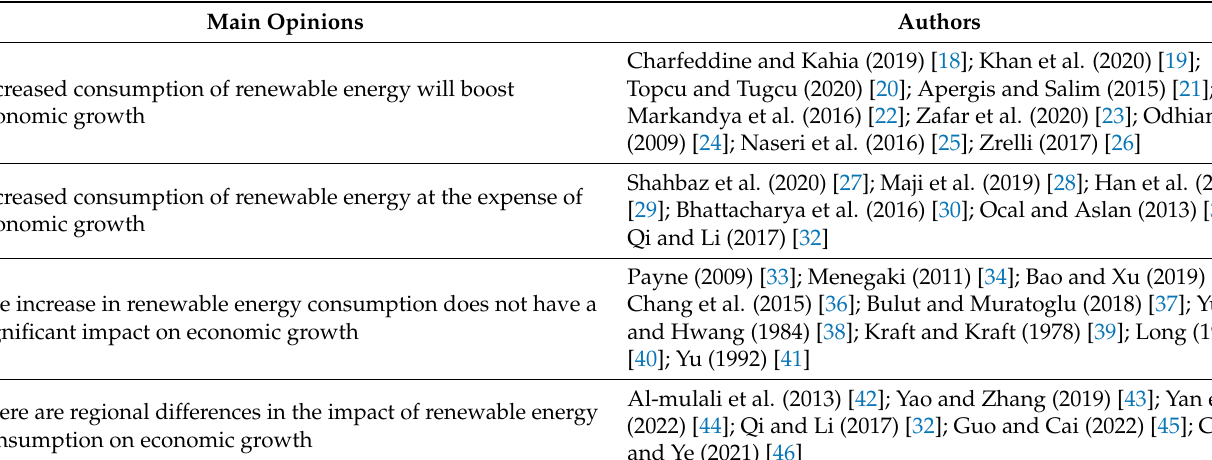
Table 1. Summary of